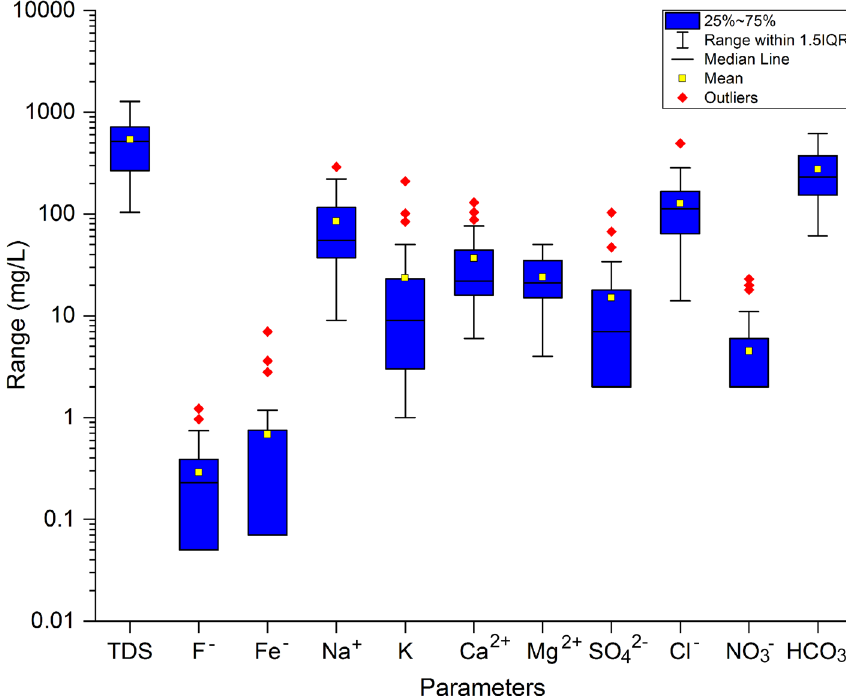
Fig. 4 Box plot showing the nature of the major ionic